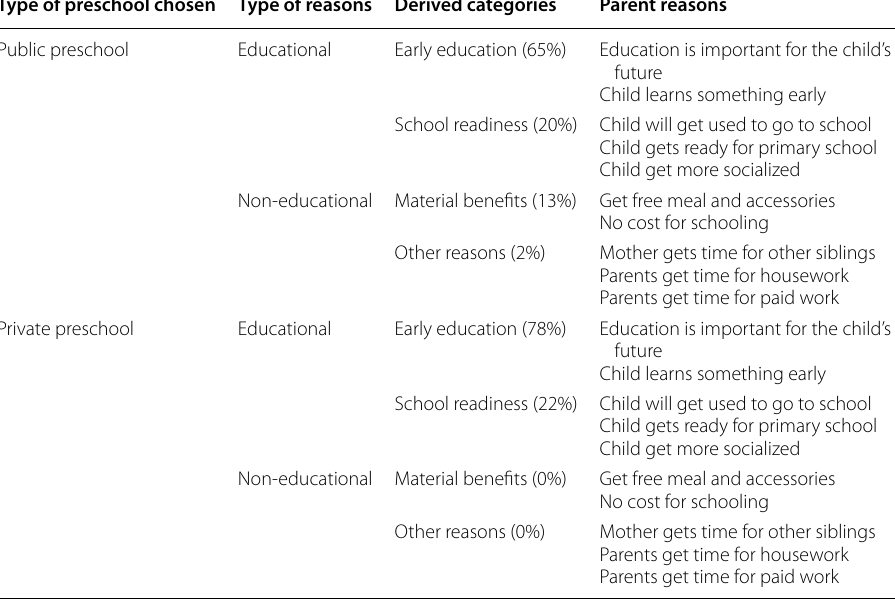
Values in parentheses represent the percentage of total parents responded to a certain category